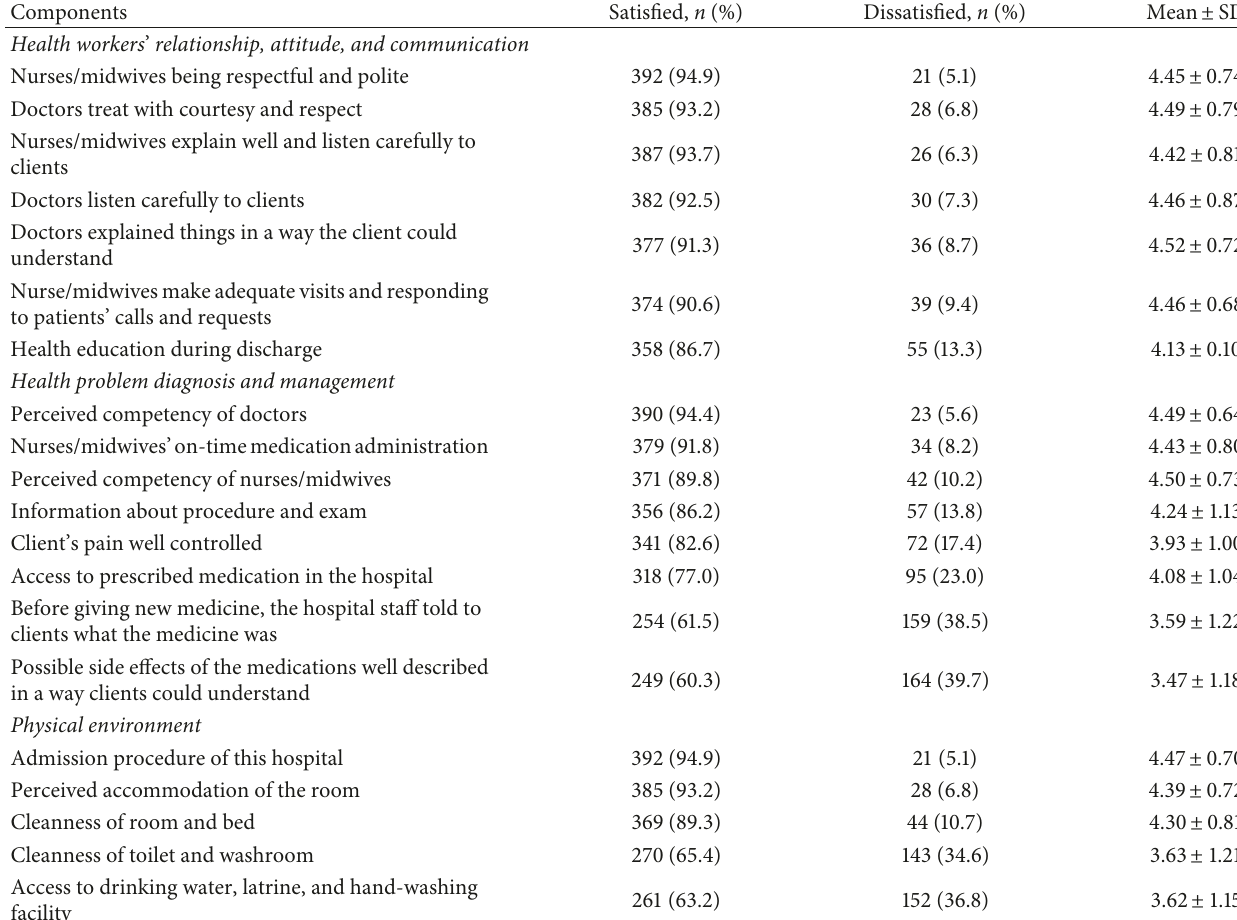
Figure 1: Overall satisfaction rate and aspects of satisfaction tool items of the respondents admitted to obstetrics and gynecology wards of public hospitals in Mekelle town, Tigray Region, 2016. Table 3: Satisfaction rate of each tool used to measure the overall satisfaction of clients admitted to obstetrics and gynecology wards of public hospitals in Mekelle town, Tigray Region,